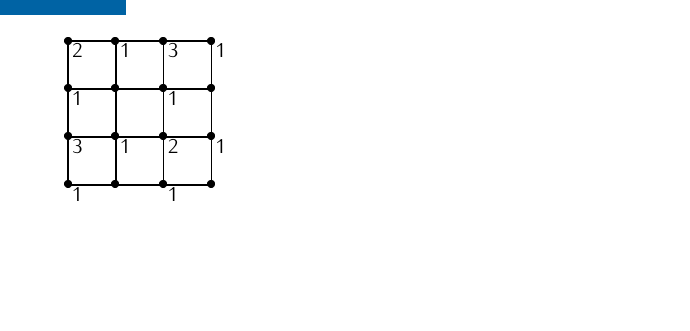
Figure 2. The basis colouring of each